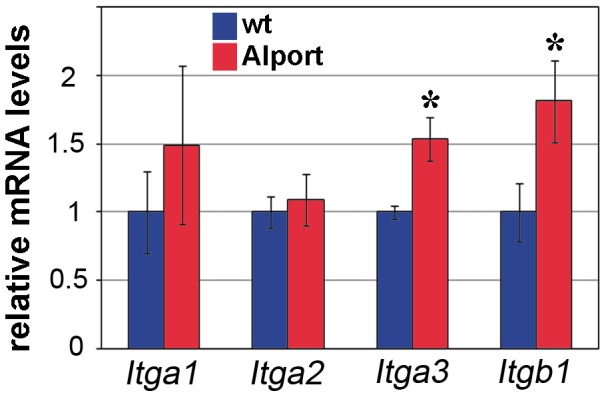
The mRNA levels encoding Itga3 and Itgb1 are upregulated in Alport glomeruli.Quantitative real time RT-PCR was performed on n = 3 wild-type (wt, blue) and n = 3 Alport (red) glomerular RNA isolated at 4 weeks of age. Both Itga3 and Itgb1 mRNAs are significantly increased in Alport glomerular RNA. * p = 0.02.